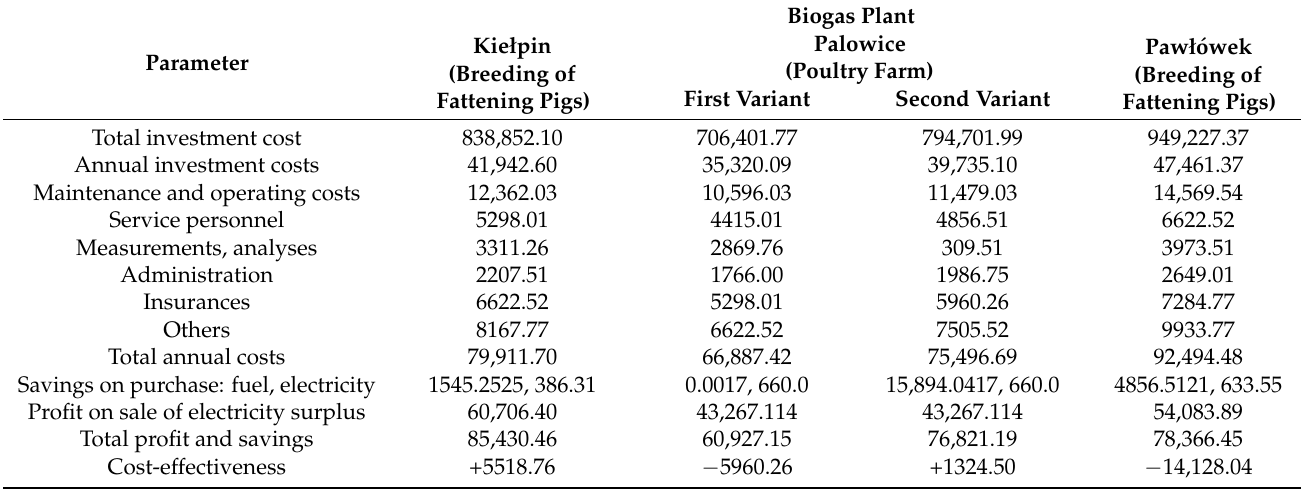
Table 4. Statement of costs, profits, and savings of biogas investments in EUR